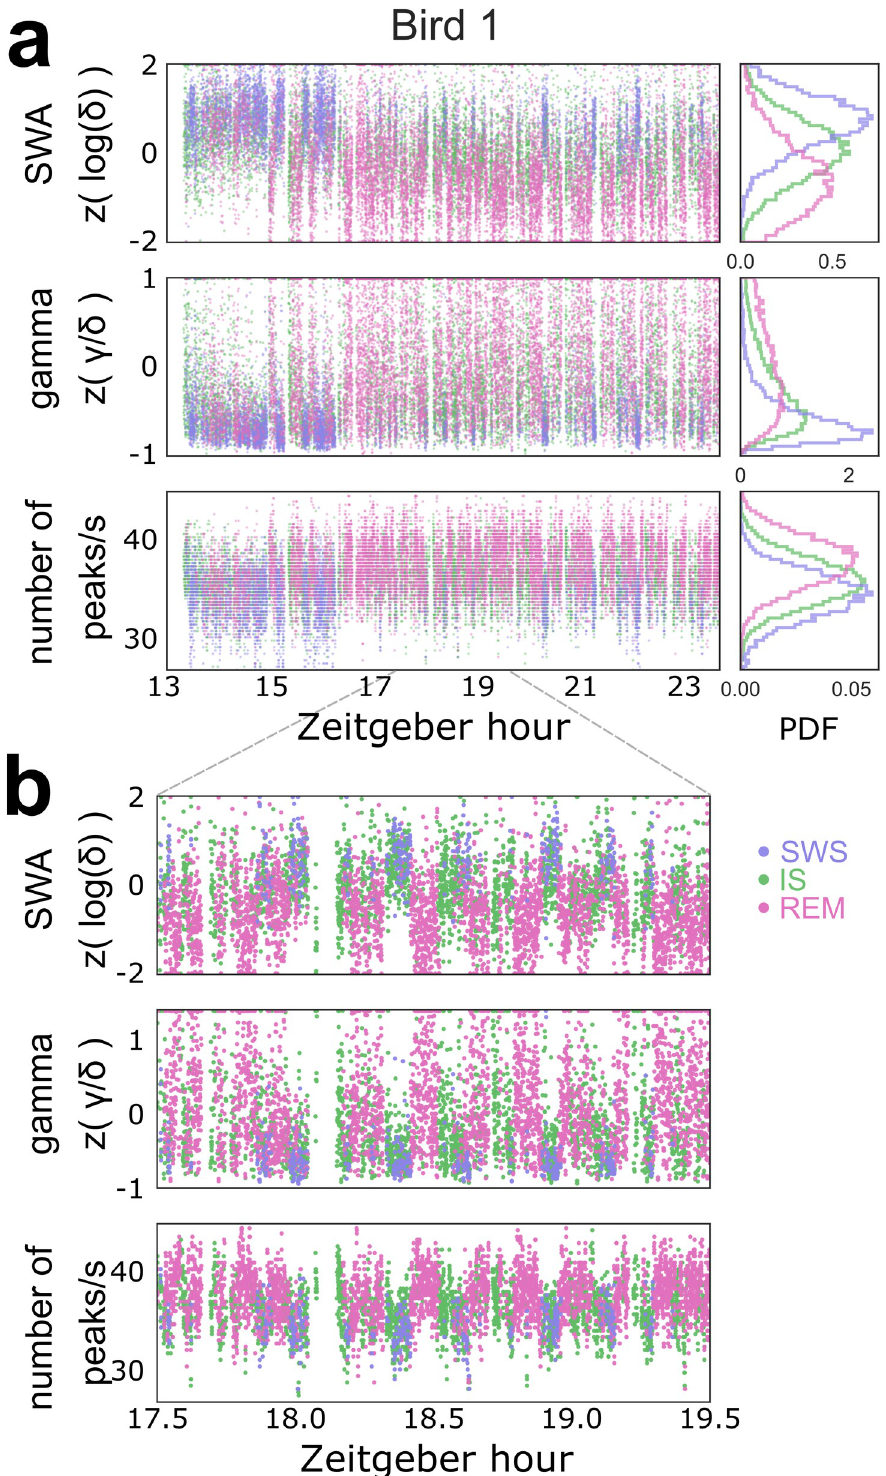
Fig 5. Coordinated ultradian oscillations in sleep characteristics. (a) An example of time-varying spectral characteristics of single-channel EEG data across the night. Dots represent epochs spaced 1 s apart. Colors indicate sleep stage. Top: z-scored log of delta per epoch. Middle: z-scored gamma/delta ratio per epoch. Bottom: number of peaks per second, a measure of the prevailing high-frequency rhythm. Right: histograms depicting the